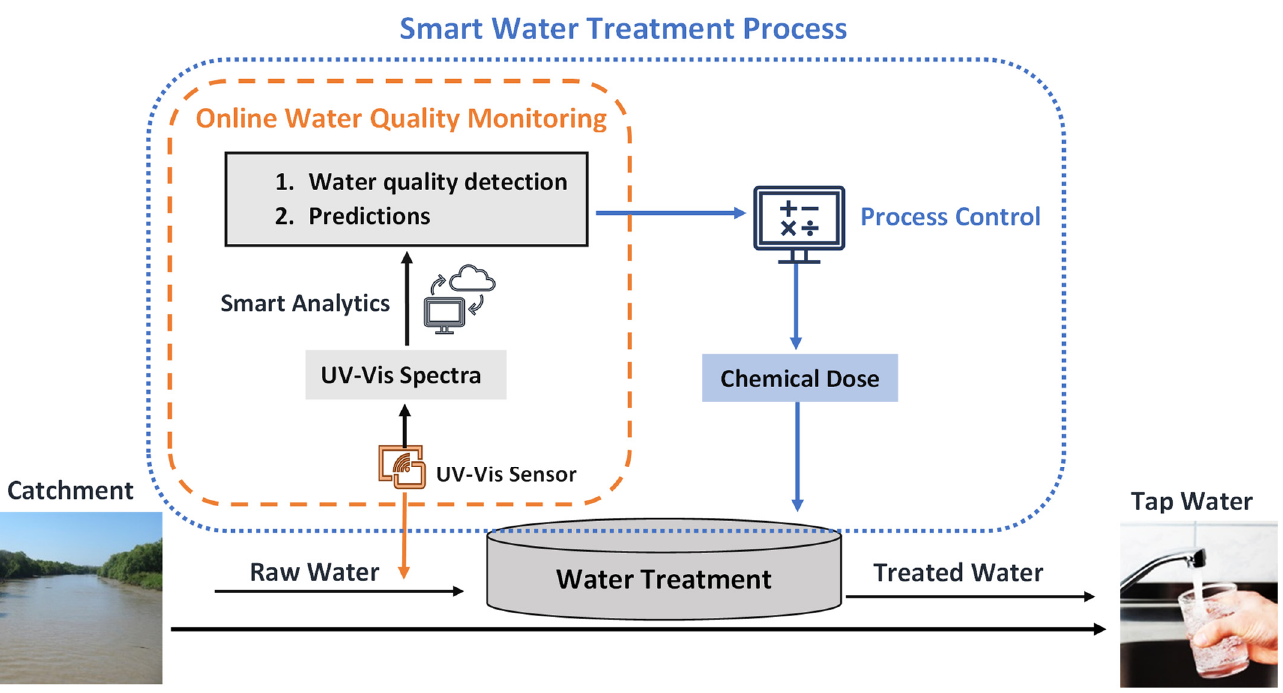
Figure 3. Applications of online UV-Vis sensors for real-time water quality monitoring and process control. Table 3. Summary of field applications of online UV-Vis spectrophotometers.